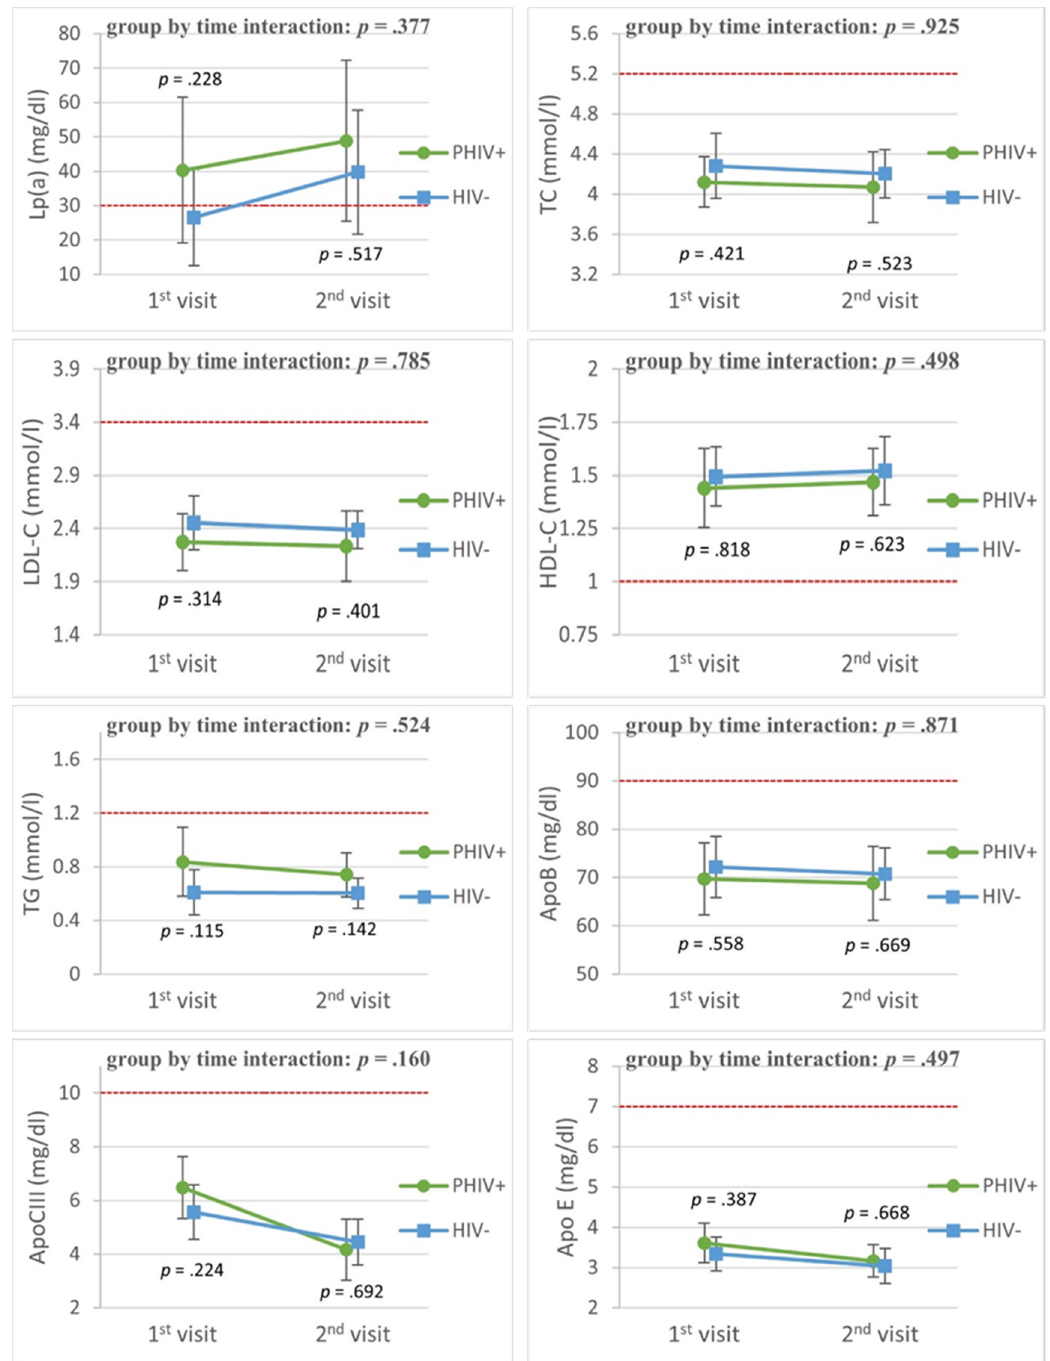
Figure 2. Lipid trends in cohort substudy. The graphs show longitudinal changes in lipid profiles of PHIV+ adolescents compared to controls matched for age, sex, ethnic background and socio-economic status. The figures show plotted least square means and their 95% confidence interval. P values are the unadjusted group by time interaction and cross-sectional difference at first and second visit. The red dashed lines show the reference values. The figures show the following lipids (with reference value in brackets): Lp(a) = lipoprotein(a) (analysis performed with logarithmical values); ApoB = apolipoprotein B; ApoCIII = apolipoprotein CIII; ApoE = apolipoprotein E; TC = total cholesterol; LDL-C = low-density lipoprotein cholesterol; HDL-C = high-density lipoprotein cholesterol; TG = triglycerides. Reference values: Lp(a) = 30 mg/dL, TC ≥ 5.2 mmol/L (200 mg/dL), LDL ≥ 3.4 mmol/L (130 mg/dL), HDL ≤ 1 mmol/L (40 mg/dL), TG ≥ 1.2 mmol (110 mg/dL) for children aged < 10 years and ≥ 1.7 mmol (150 mg/dL) for children aged ≥ 10 years, ApoB < 90 mg/dL, ApoCIII ≈ 10 mg/dL, ApoE 3–7 mg/dL.